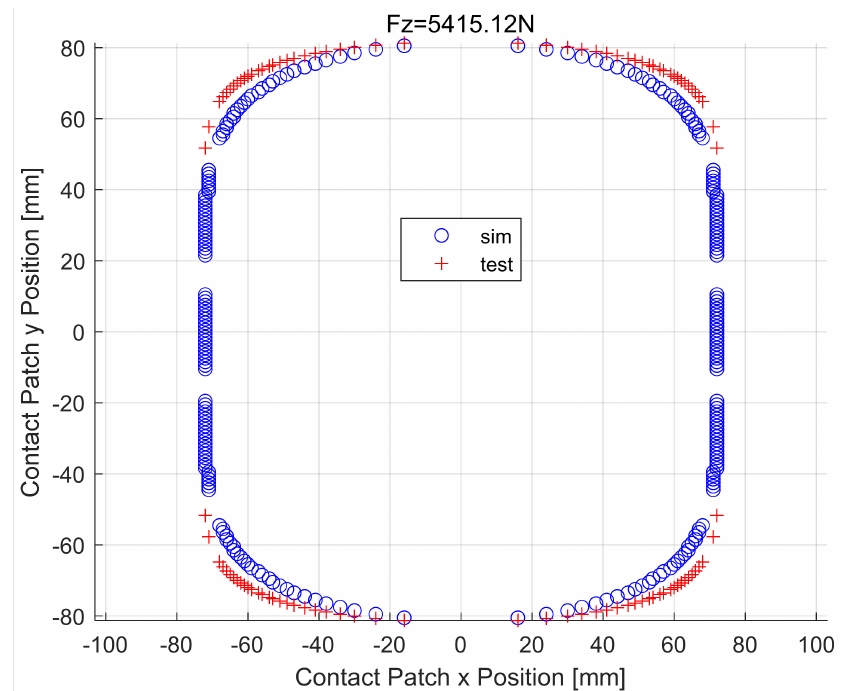
Figure 7. Contact patch shape comparison between model and test.